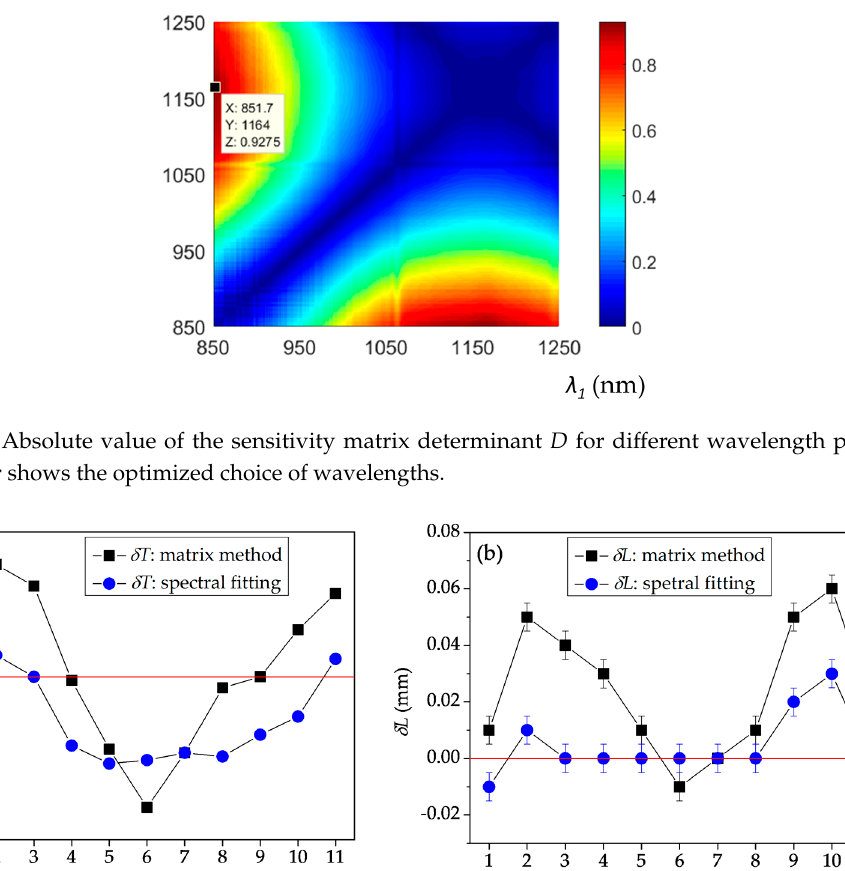
Figure 11. The differences between applied values of ( a ) temperature and ( b ) elongation, and the values retrieved by the two-wavelength method and spectral fitting method. The red lines indicate zero levels.